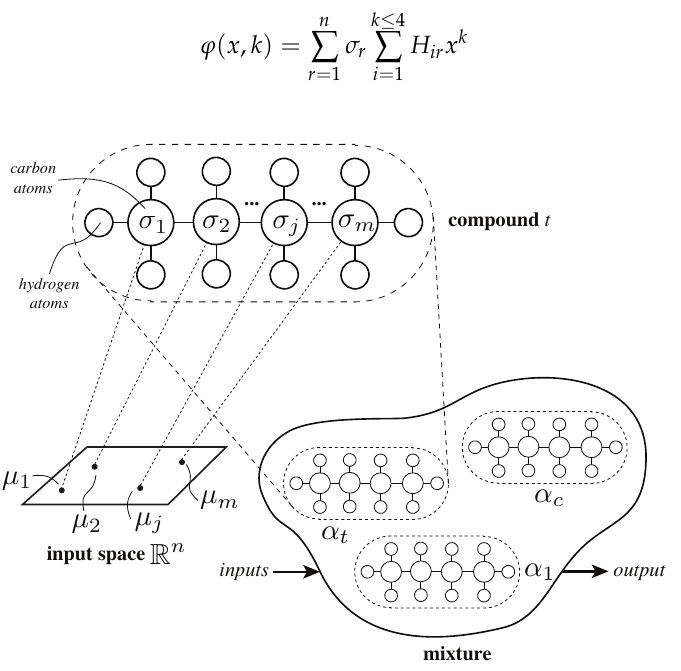
Figure 7. Schematic of an artificial hydrocarbon